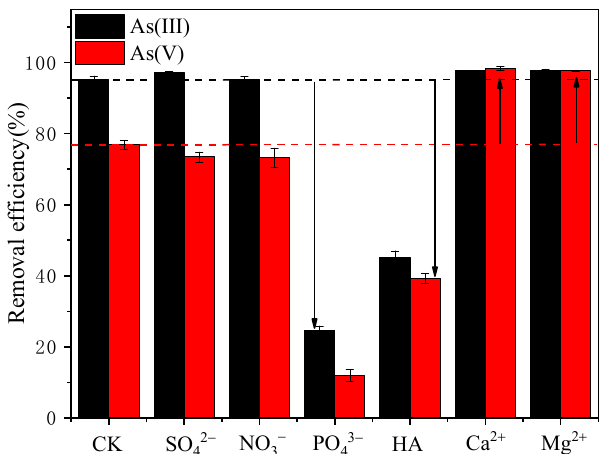
Figure 3. Influence of coexisting ions (SO 42 − , PO 42 − , Ca 2+ , Mg 2+ , and NO 3 − ) and HA on As(III) and As(V) adsorption (experimental conditions: pH = 7). ‘CK’ stands for ‘control check’, which means no competing ions existed in the aqueous solution.